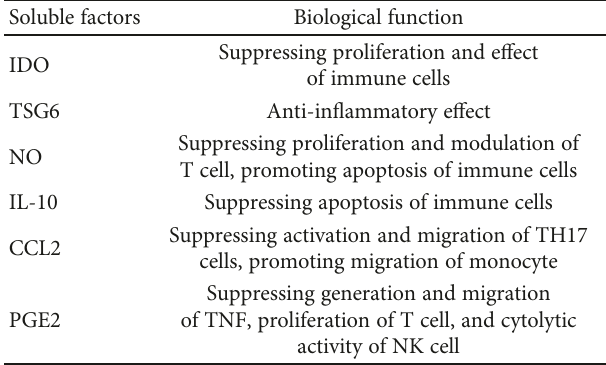
Table 2: Biological function of soluble factor secreted by MSCs. Soluble